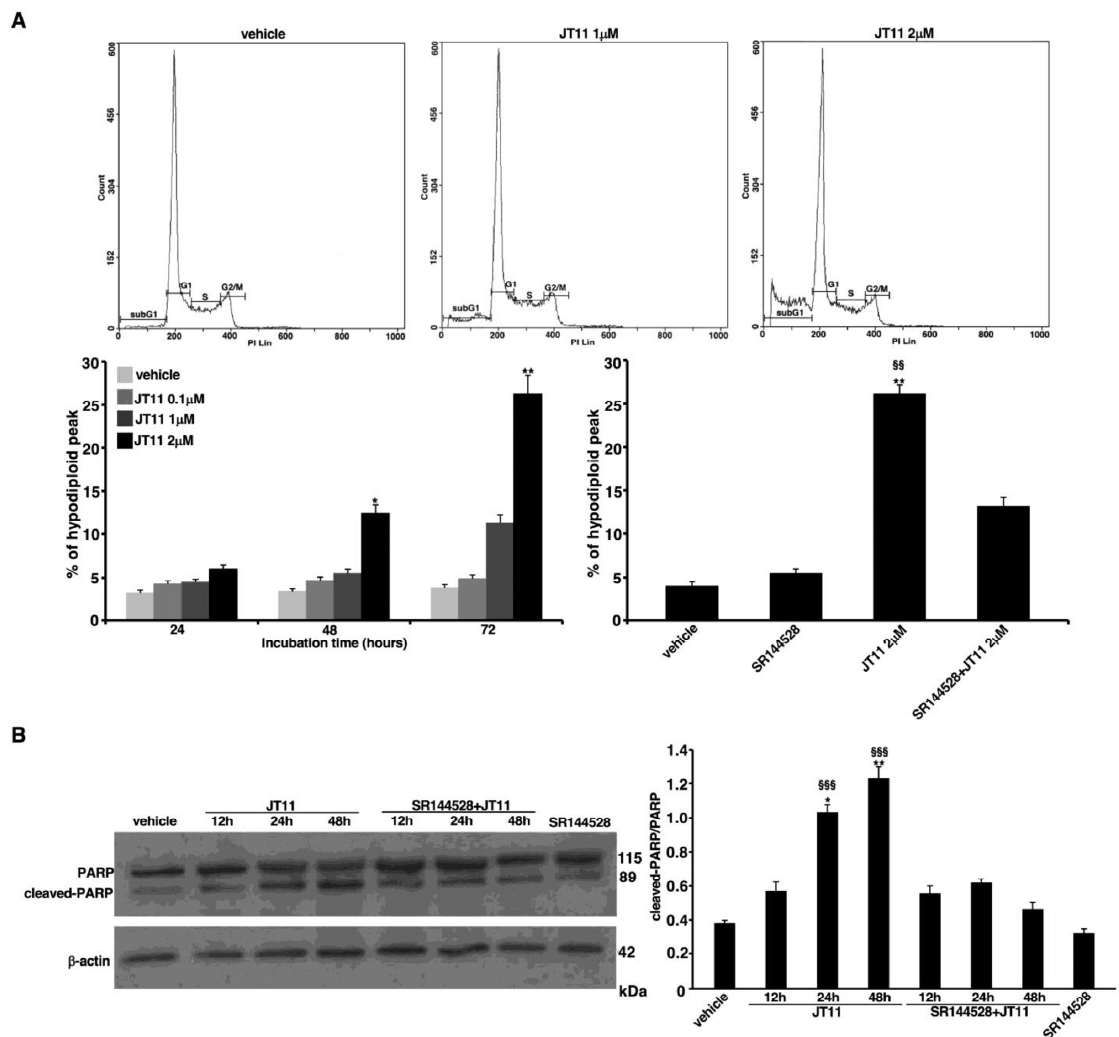
Figure 3. JT11 exhibits a CB2R-dependent pro-apoptotic effect in Jurkat cells. ( A ) Jurkat cells were incubated with a 0.1, 1, or 2 μ M JT11 for 24, 48 and 72 h, and their DNA content was measured by flow cytometry after propidium iodide (PI) staining. The histograms show the distribution of cells in the phases of cell cycle based on their DNA content, and the amplitude of the subG1 peak, i.e., the percentage of hypodiploid peak, indicates the percentage of dead cells; Percentage of cells with hypodiploid DNA content. Data are reported as mean ± SD from three independent experiments. * p < 0.01 vs. vehicle; ** p < 0.001 vs. vehicle; PI staining was performed also in the presence of 1 μ M SR144528. Data are reported as mean ± SD from three independent experiments. ** p < 0.001 vs. vehicle; §§ p < 0.001 vs. SR144528 + JT11; ( B ) Analysis of poly (ADP ribose) polymerase (PARP) cleavage by Western blot. Jurkat cells were treated with 2 μ M JT11, or alternatively pretreated with 1 μ M SR144528 and then incubated with 2 μ M JT11 for 12, 24 or 48 h. The protein extracts were separated by sodium dodecyl sulphate-polyacrylamide gel electrophoresis (SDS-PAGE) and analyzed using anti-PARP antibody (Ab). The loading control was evaluated using anti- β -actin Ab;